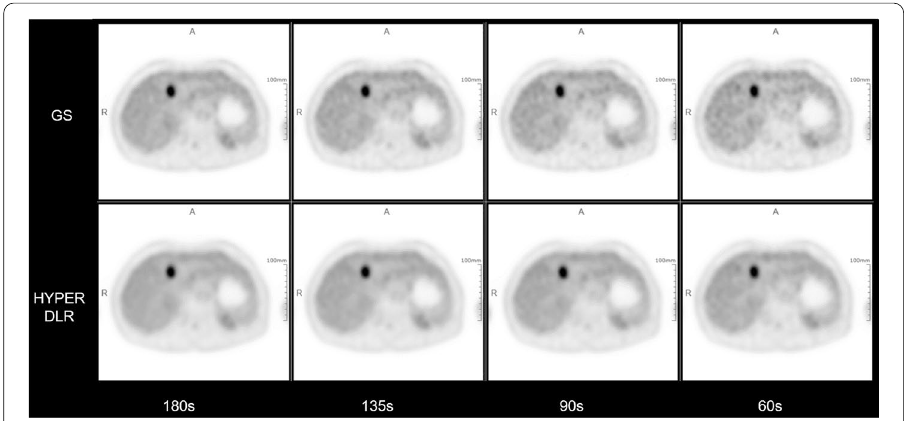
Fig. 3 Transverse images of the liver metastasis of an 80-year-old male patient with renal cancer. The upper and bottom row were reconstructed with GS and HYPER DLR approach, respectively. The acquisition time is 180, 135, 90, and 60 s (left to right). The bottom row shows the superior performance in noise reduction